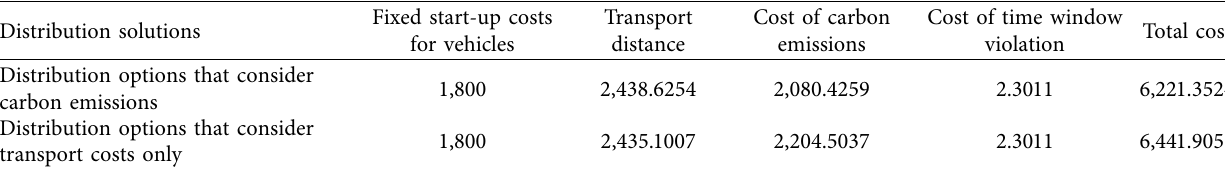
Table 10: Cost comparison of two distribution